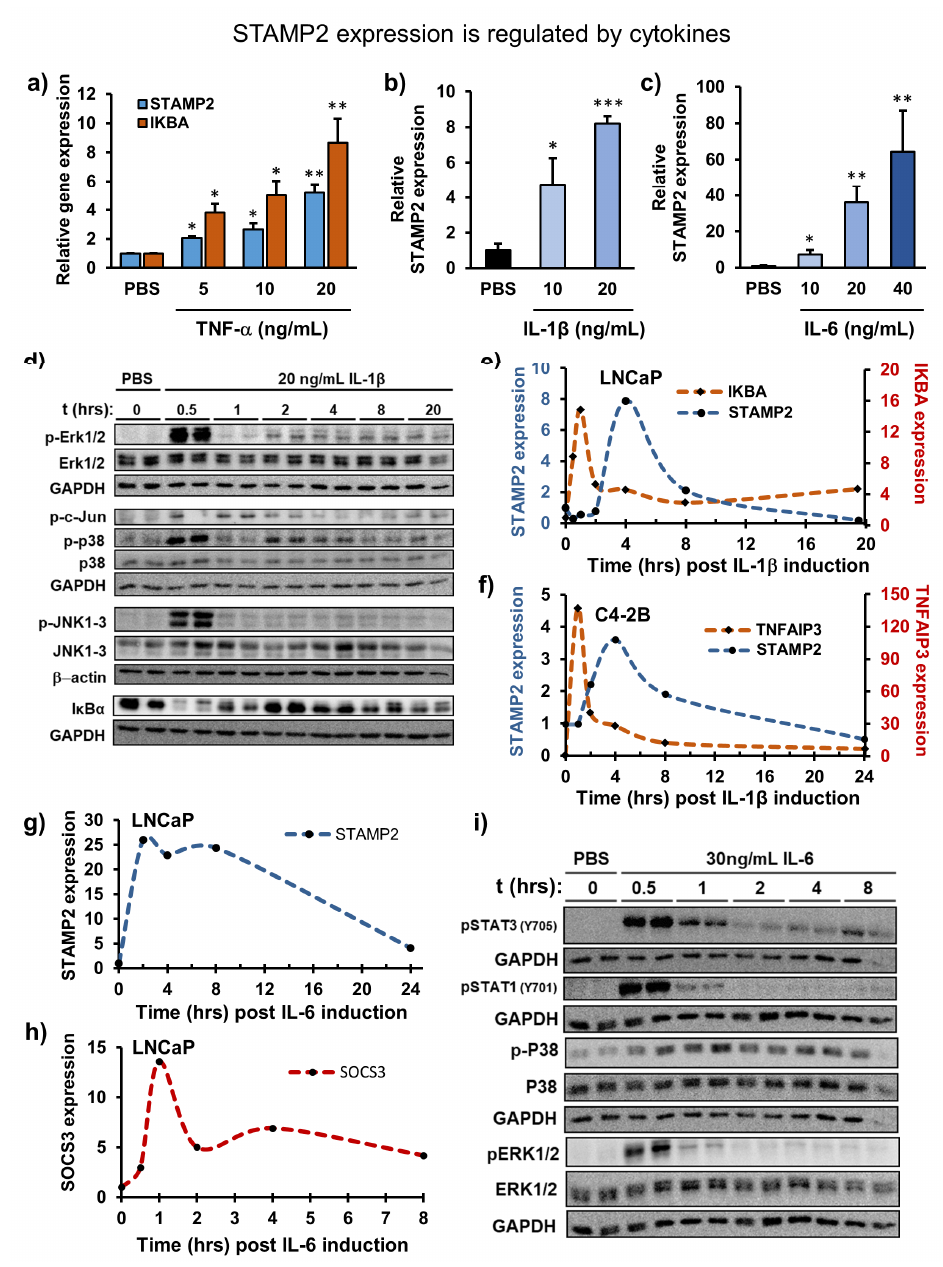
Figure 2. STAMP2 expression is regulated by cytokines. ( a – c ) LNCaP cells were serum-starved and then induced with different concentrations of TNF ( a ), IL-1 β ( b ), or IL-6 ( c ) for 16 h. Total RNA was then harvested and subjected to qRT-PCR analysis. Statistics shown by asterisks are relative to PBS treatments. ( d ) LNCaP cells were serum-starved before induction with 20 ng/mL IL-1 β . Whole-cell lysates were harvested at the indicated timepoints and subjected to Western blot analysis. ( e – h ) LNCaP or C4-2B cells were serum-starved before induction with 20 ng/mL IL-1 β ( e , f ) or IL-6 ( g , h ). Total RNA was harvested at the indicated timepoints and subjected to qRT-PCR analysis. ( i ) LNCaP cells were serum-starved before induction with 30 ng/mL IL-6. Whole-cell lysates were harvested at the indicated timepoints and subjected to Western analysis. pSTAT3, pP38, and p38 blots were developed from the same membrane, and share the same GAPDH as the endogenous control. Similarly, pSTAT1 pERK1/2 and ERK1/2 were developed from the same membrane and hence share the same GAPDH. Asterisks above the bar graphs indicate statistics compared to PBS treatments. * p < 0.05, ** p < 0.01, *** p <